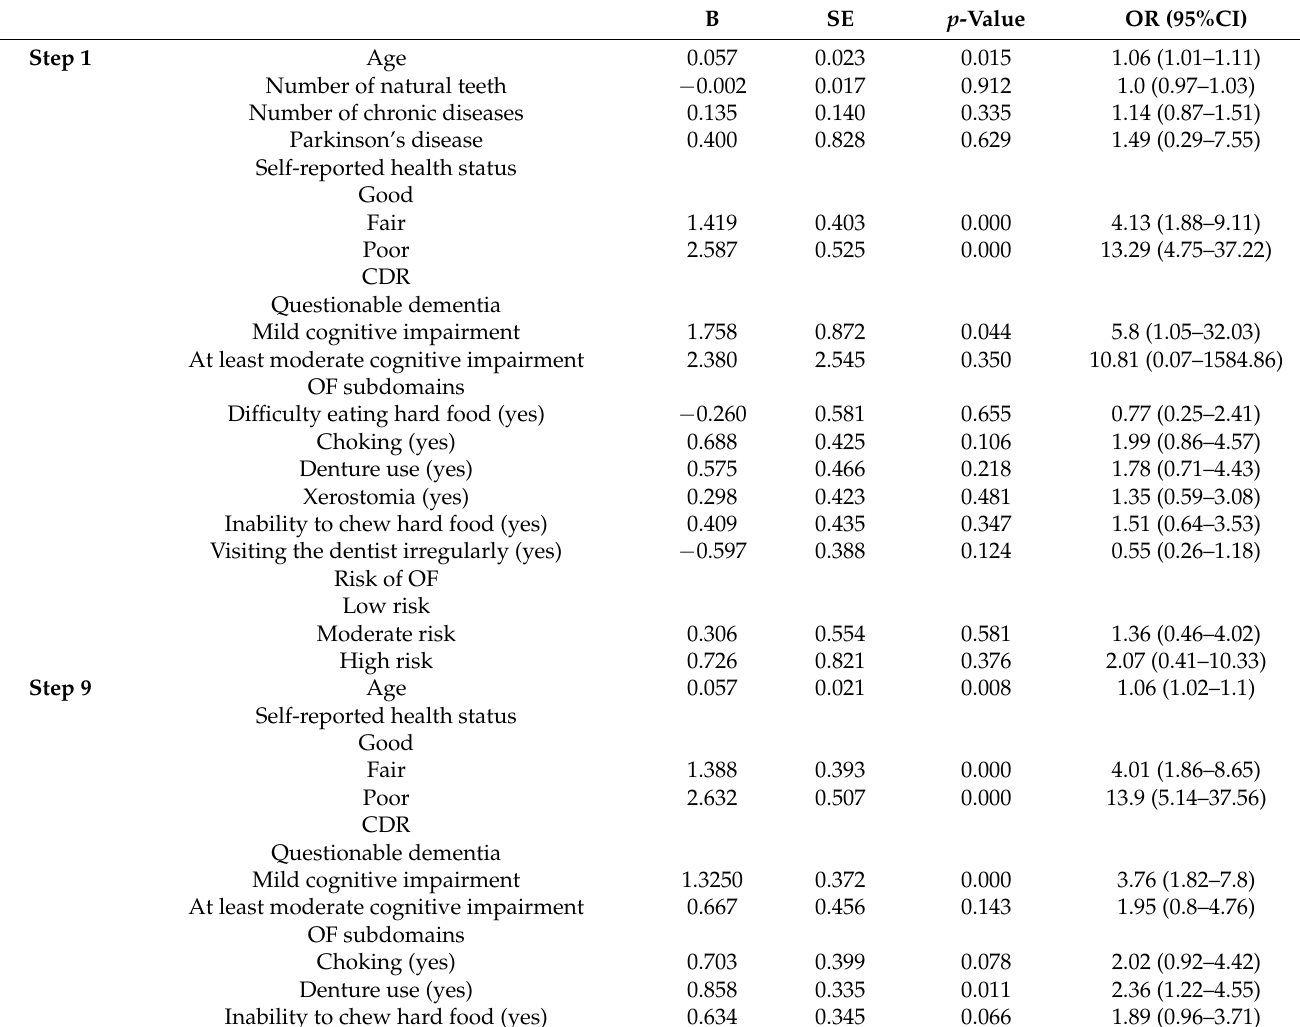
Table 4. The association of independent variables and physical